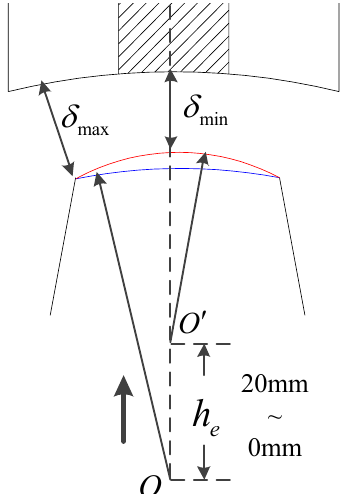
Figure 9. The model of rotor with eccentric